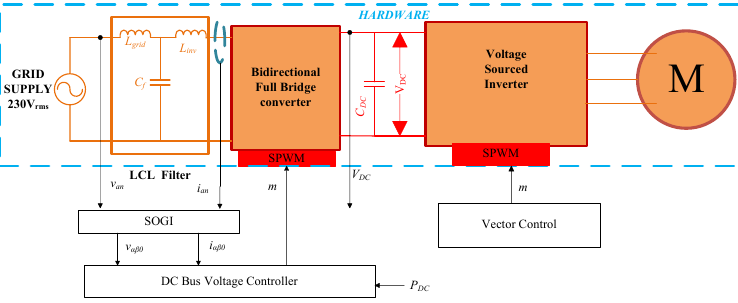
Figure 2. A simplified schematic diagram of the modified VSHP